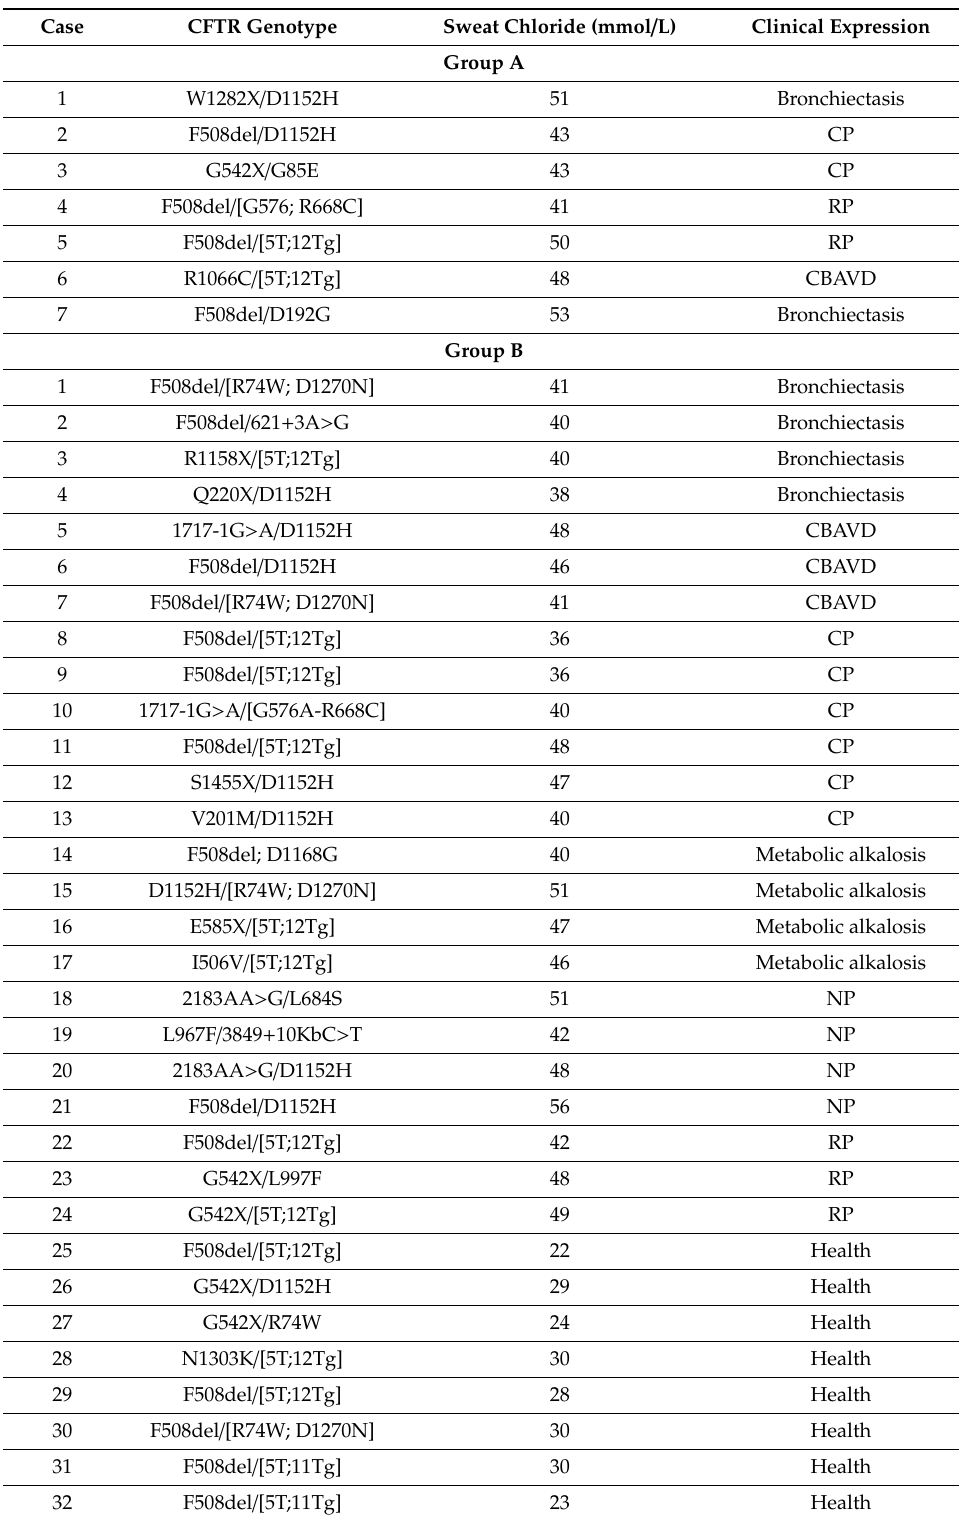
Table 1. Subjects diagnosed as cystic fibrosis transmembrane regulator-related disorders (CFTR-RD) by symptoms (A) or following molecular analysis in the absence of reported symptoms (B). CBAVD,